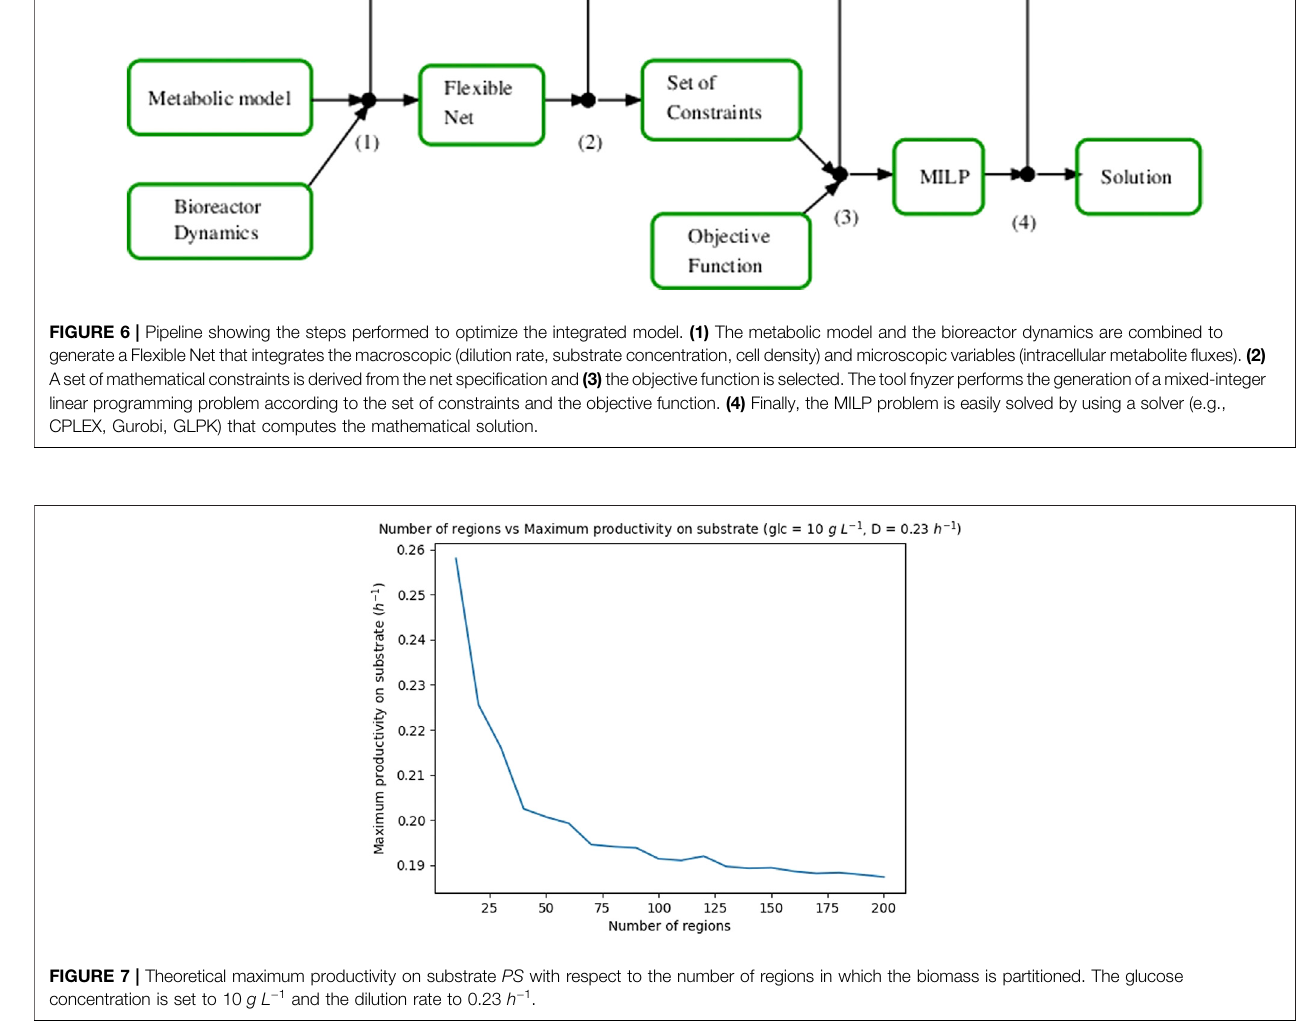
Frontiers in Molecular Biosciences |